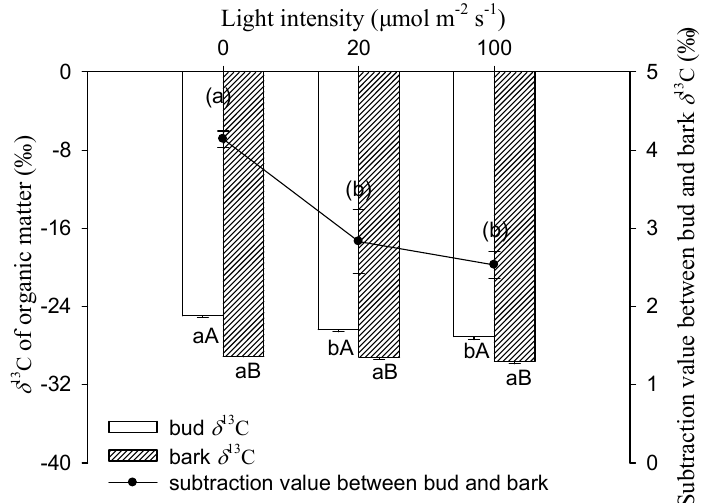
Figure 5. δ 13 C of bud or bark organic matter and the subtraction value between them in cutting seedlings. Data were mean ± SE with n = 3. For the δ 13 C of bud and bark, statistical differences ( p < 0.05) between (i) treatments for a given organ (different lowercase letters) and (ii) organs for a given treatment (different capital letters) were determined. For the subtraction value between bud and bark δ 13 C, the different lowercase letters within the parenthesis indicate a significant difference ( p < 0.05).